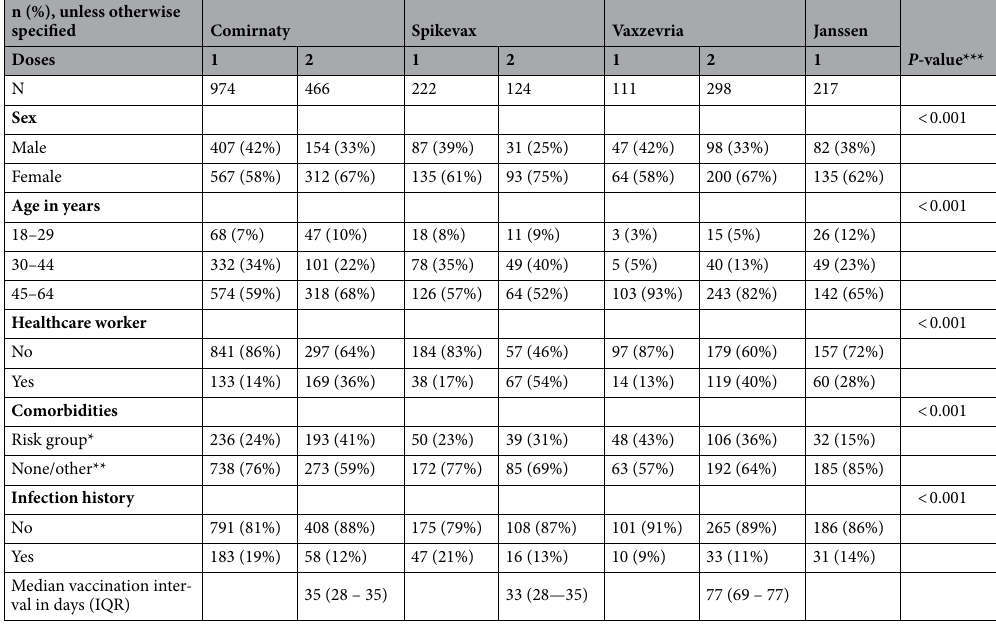
Table 1. General characteristics of SARS-CoV-2 vaccinated adults aged 18–64 years up to two months following the first or second dose by vaccination brand and number of doses (n = 2,412). * High risk comorbidities: asthma or other lung disease, cardiovascular disease, diabetes, (history of) cancer, history of transplantation, kidney disease, immune disease, splenectomy, liver disease, rheumatoid arthritis, intestinal disease, neurological disease, or other (open field). Persons with these comorbidities were prioritized during the vaccination campaign in the Netherlands as they were considered high risk for severe COVID-19. **Other comorbidities: hay fever, skin disease or allergies. ***Chi-squared tests were used to test for statistical differences between groups. IQR: interquartile